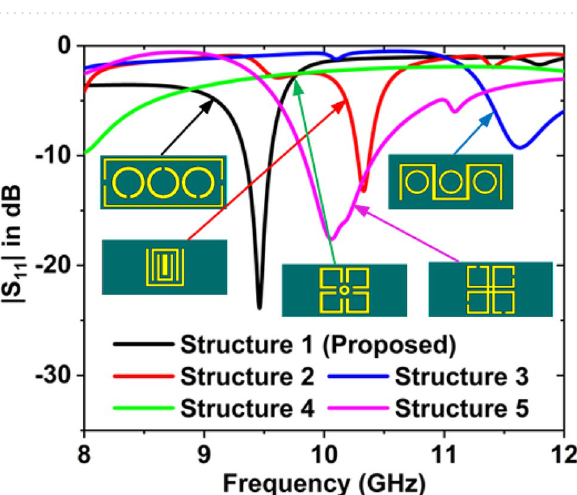
Figure 3. ( a ) Design procedure ( b ) Reflection coefficient ( S 11 ) for various design steps.